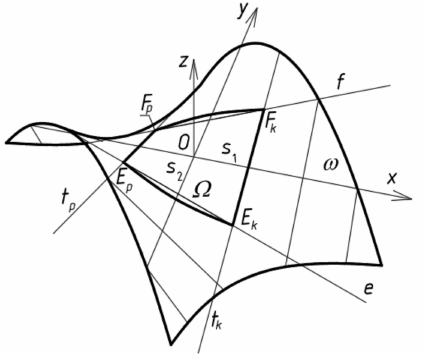
Figure 17. Z-axis-symmetrical sector Ω of right hyperbolic paraboloid ω adopted as a model for a corrugated transformed